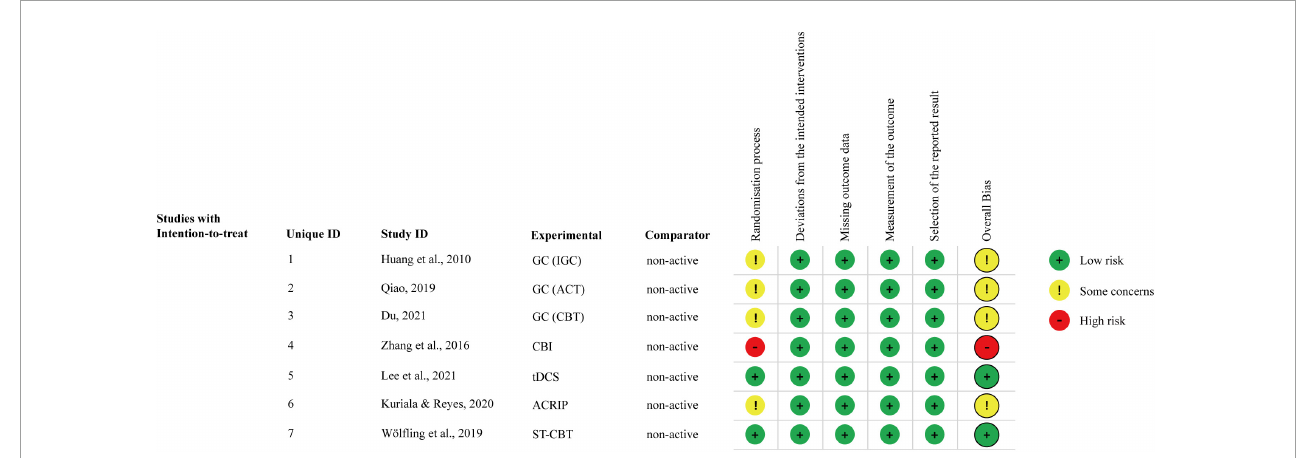
FIGURE3 Risk of bias for each included